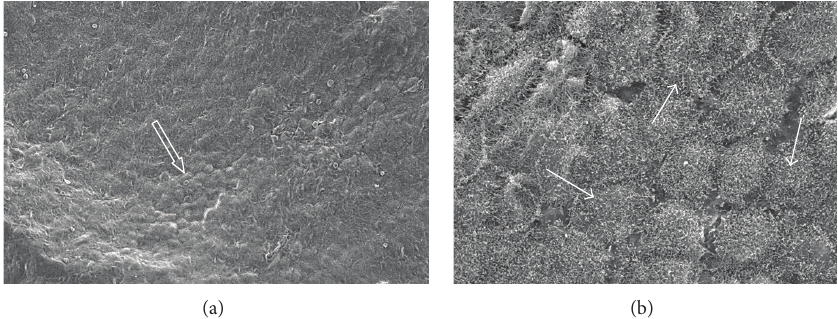
Figure 5: Mesothelial surface from rats 12h after insufflation with heated humidified CO 2 for 2 h at 5mm/Hg (group 4). The cells are tightly apposed with cytoplasmic projections (microvilli) prominent (arrows). While some rounding of the cells is evident (open arrow), overall this group showed the least effects from the induced environment: (a) original × 650; (b) original ×